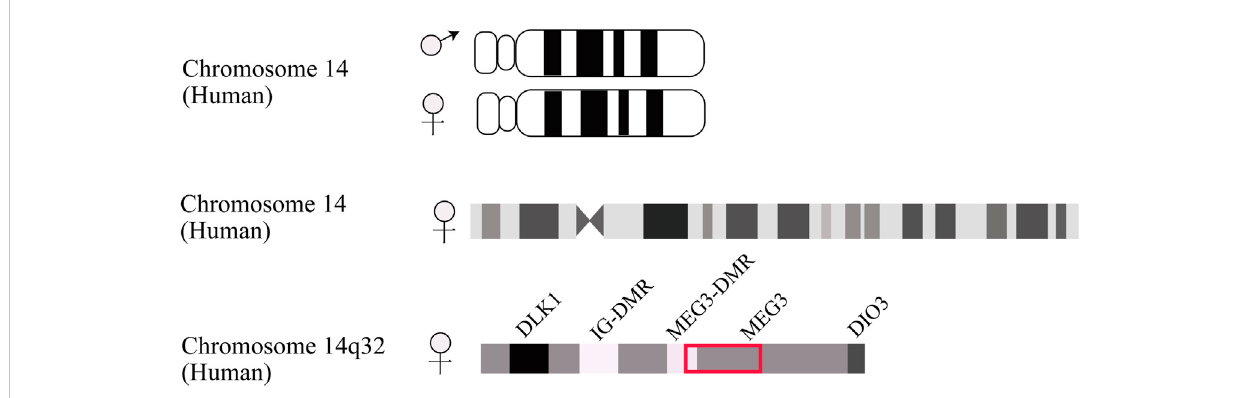
FIGURE 1 Schematic description of DLK1-MEG3 locus on human chromosome 14. The IG-DMR locates on about 13 kb upstream from MEG3 promoter. The MEG3-DMR locates on 1.5 kb upstream from MEG3 gene and overlapped with MEG3 promoter.